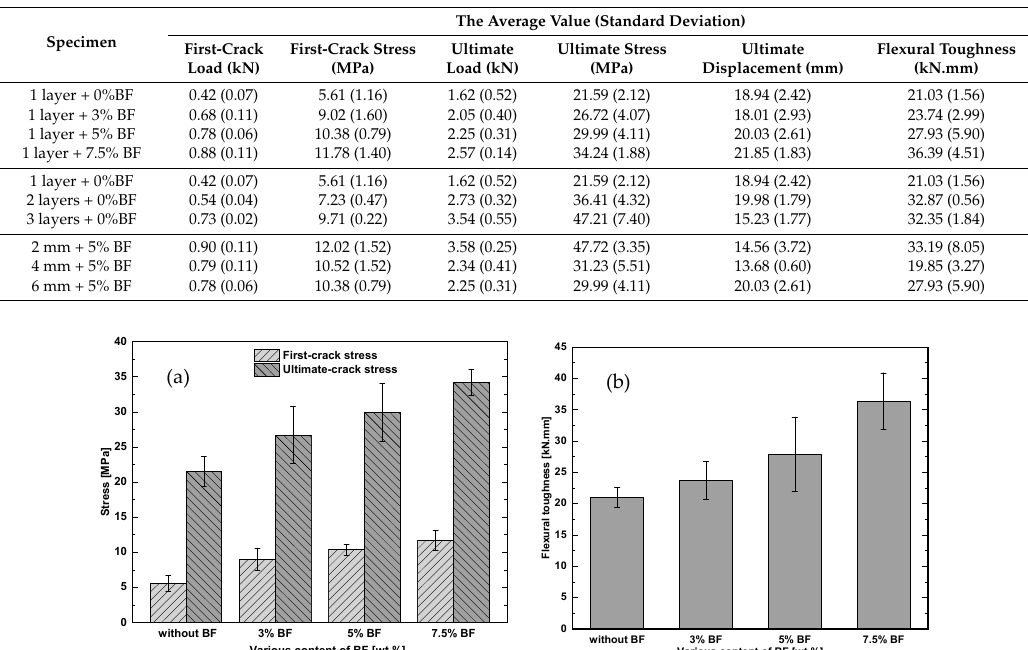
Figure 8. The mechanical strength of one textile layer reinforced specimens with the different BF contents of 0%, 3%, 5%, 7.5%: ( a ) flexural stress; ( b ) flexural toughness.